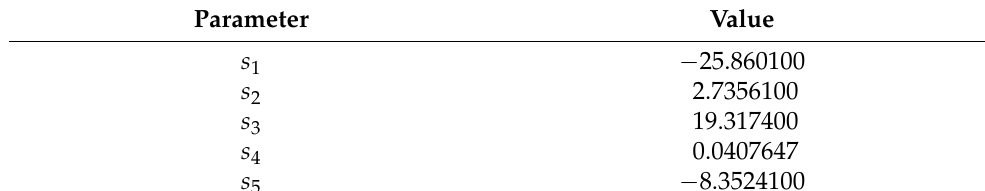
Table 2. Obtained material parameters.